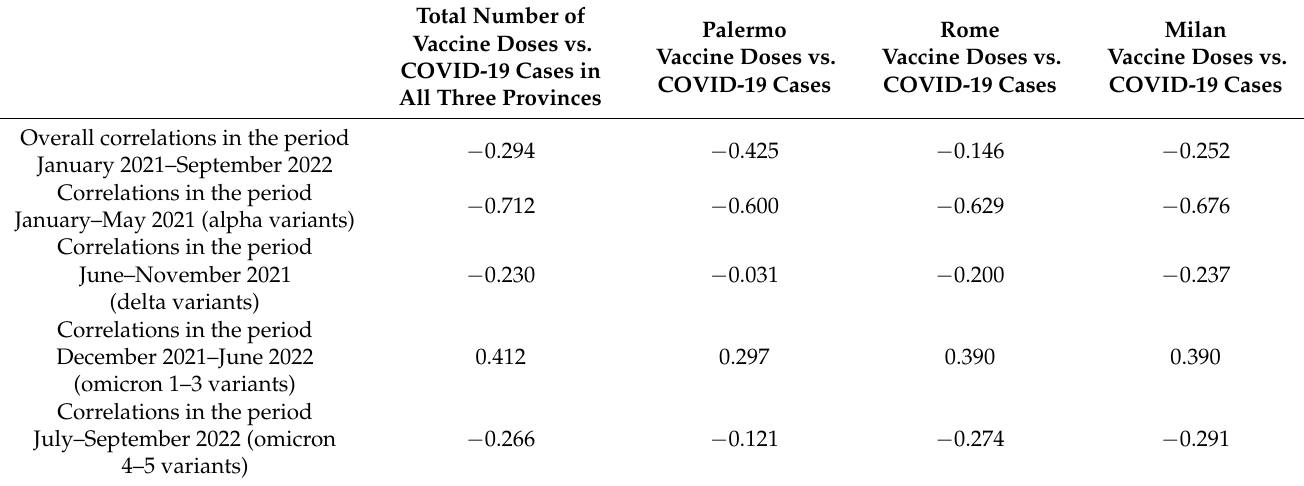
Table 2. Pearson’s r correlations of new SARS-CoV-2 infections with COVID-19 vaccine doses administered in Palermo, Rome and Milan in Italy from January 2021 to September